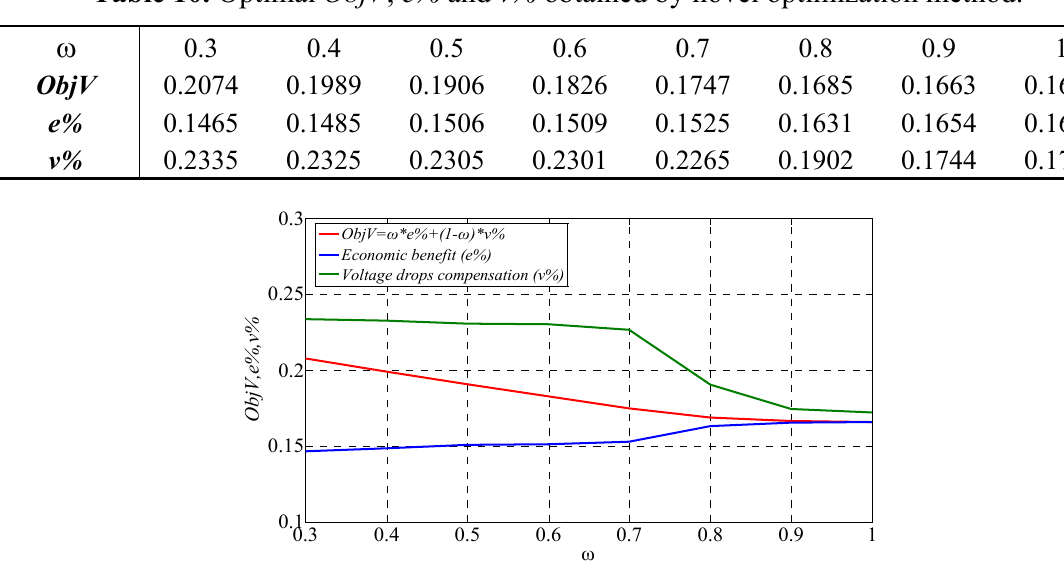
Figure 18. Best energy management strategy of ESSes. ( a ) Charging energy management strategy; and ( b ) discharging energy management strategy. Table 10. Optimal ObjV , e% and v% obtained by novel optimization method.